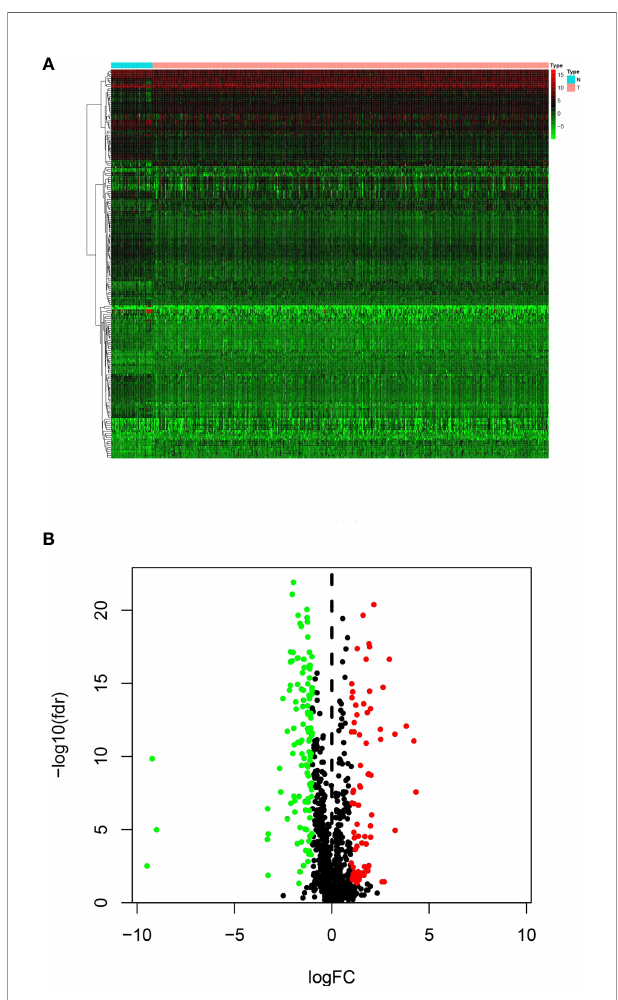
FIGURE 2 | Differentially expressed IRGs: (A) Heatmap and (B) Volcano